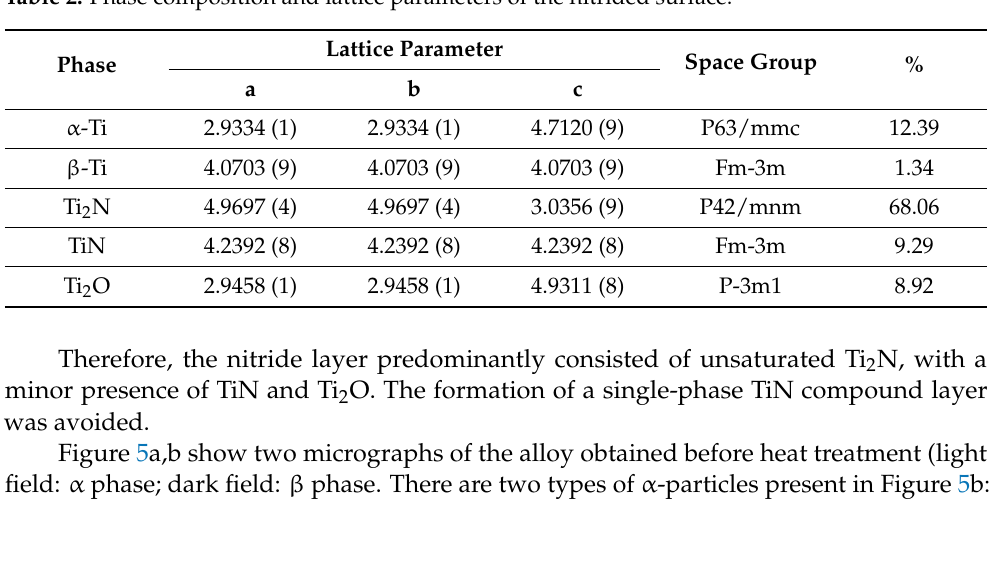
field: α phase; dark field: β phase. There are two types of α -particles present in Figure